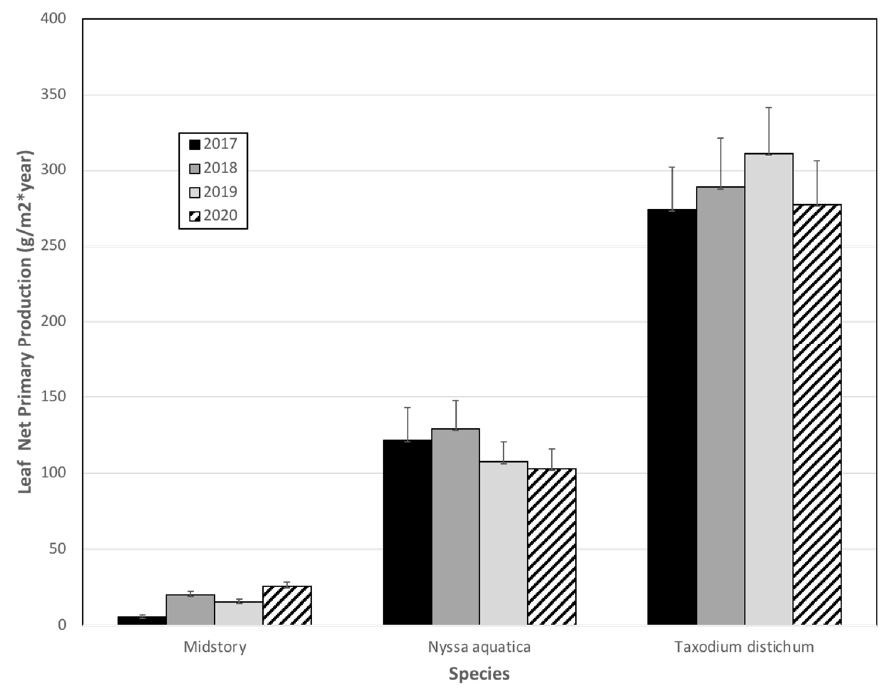
Figure 10. Leaf litter production (gm m − 2 y − 1 + s.e.) during 2017 (black), 2018 (dark gray), 2019 (light gray), and 2020 (striped) in the reference and Lac des Allemands swamp for the two canopy species ( Taxodium distichum and Nyssa aquatica ) and midstory species (nearly all of which are Acer rubrum var. drummondii ).